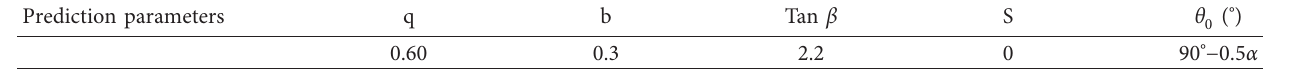
α is the inclination angle of the coal seam.